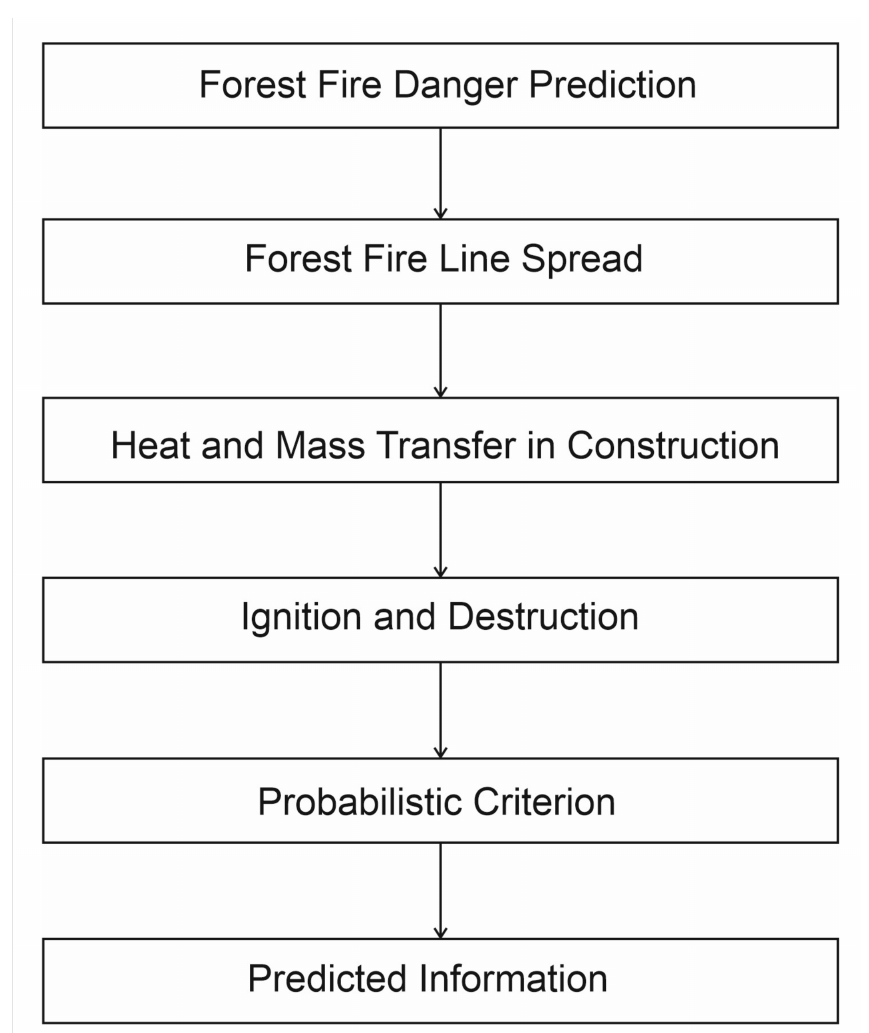
Figure 1. Forest fire impact